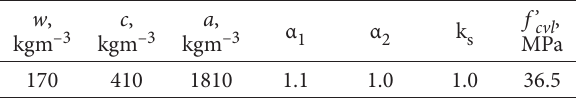
table 1. Input parameters of B3